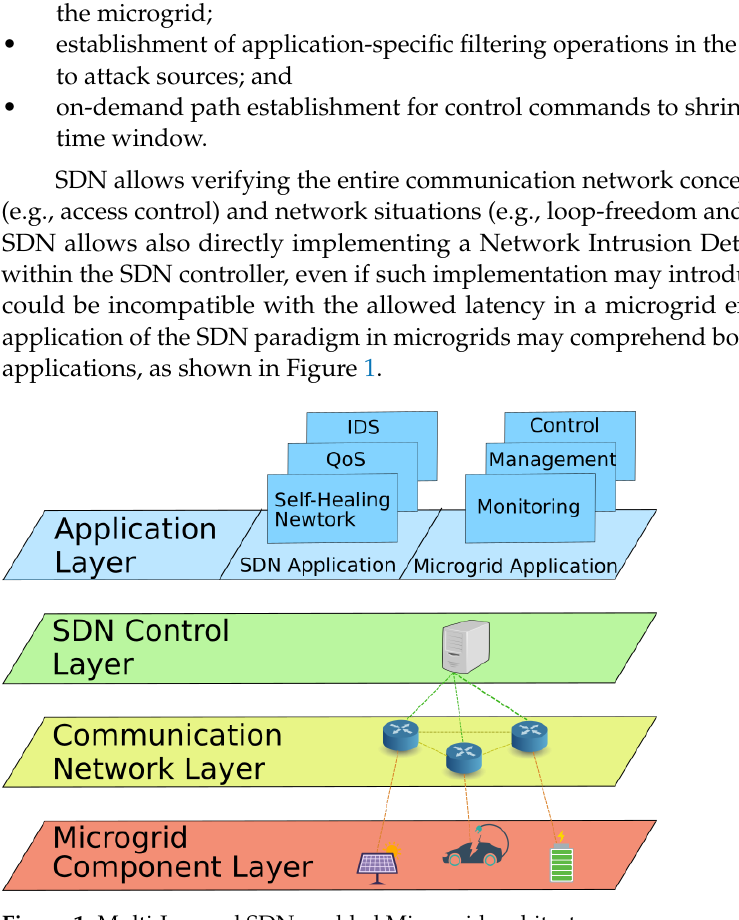
Figure 1. Multi-Layered SDN-enabled Microgrid